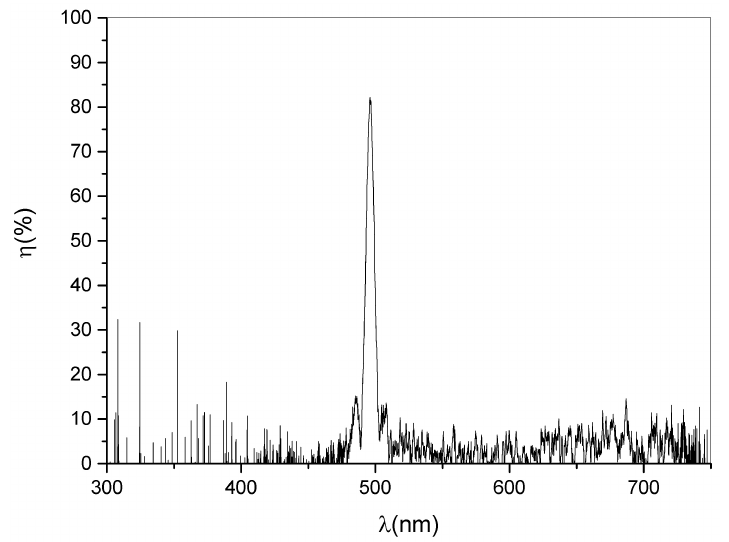
Figure 2. Best diffraction efficiency value measured using an incoherent white light source impinging at 56° with respect to the normal to the glasses.